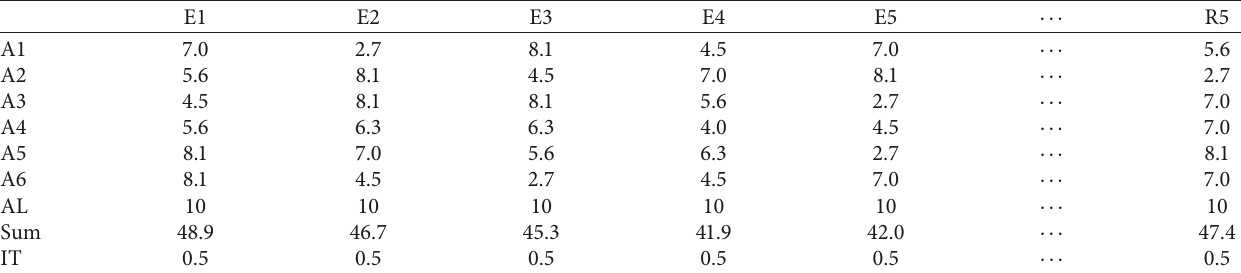
Table 12: The initial assessment matrix sc ( θ )